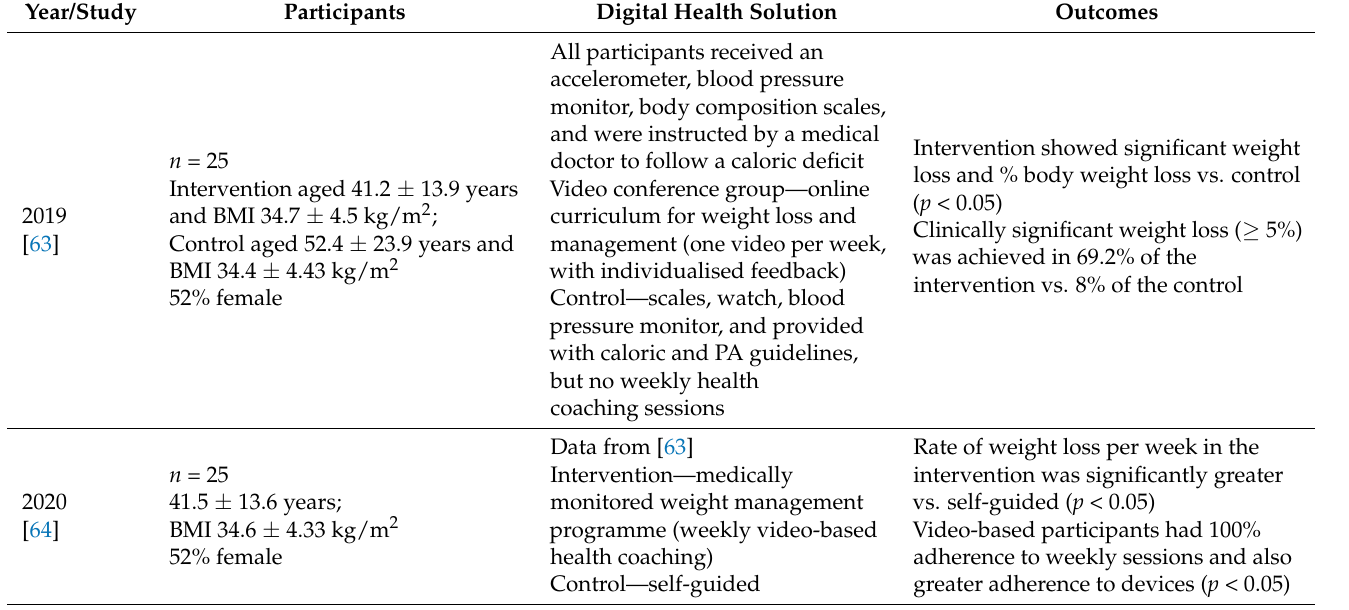
Table 3. Study characteristics for the use of a web-based